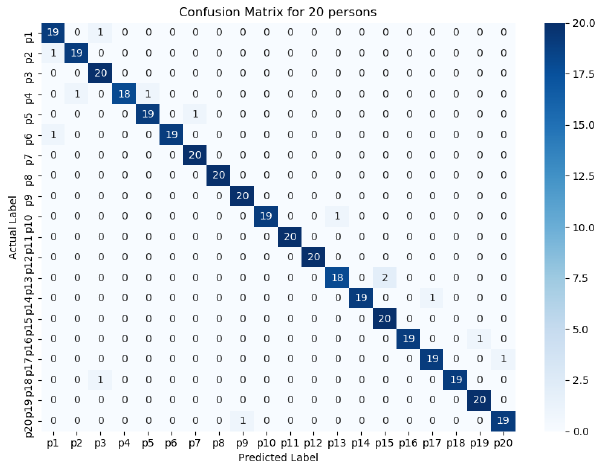
Figure 13. Confusion matrix of the proposed model for the fifteen persons.